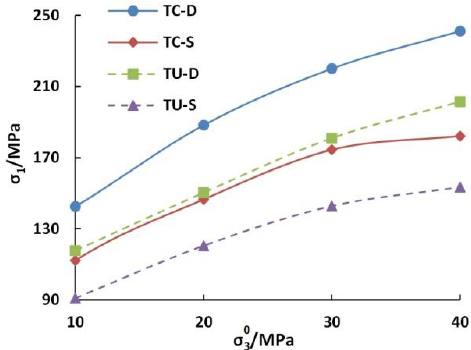
Figure 2. Peak strength of sandstone specimens.